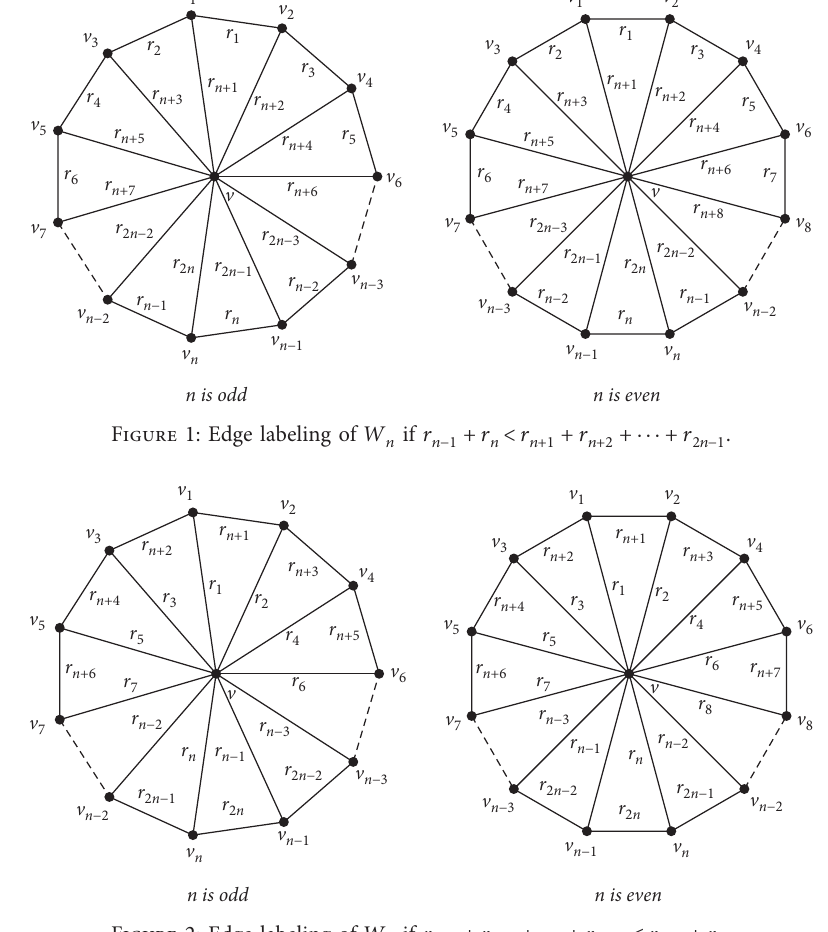
Figure 2: Edge labeling of W